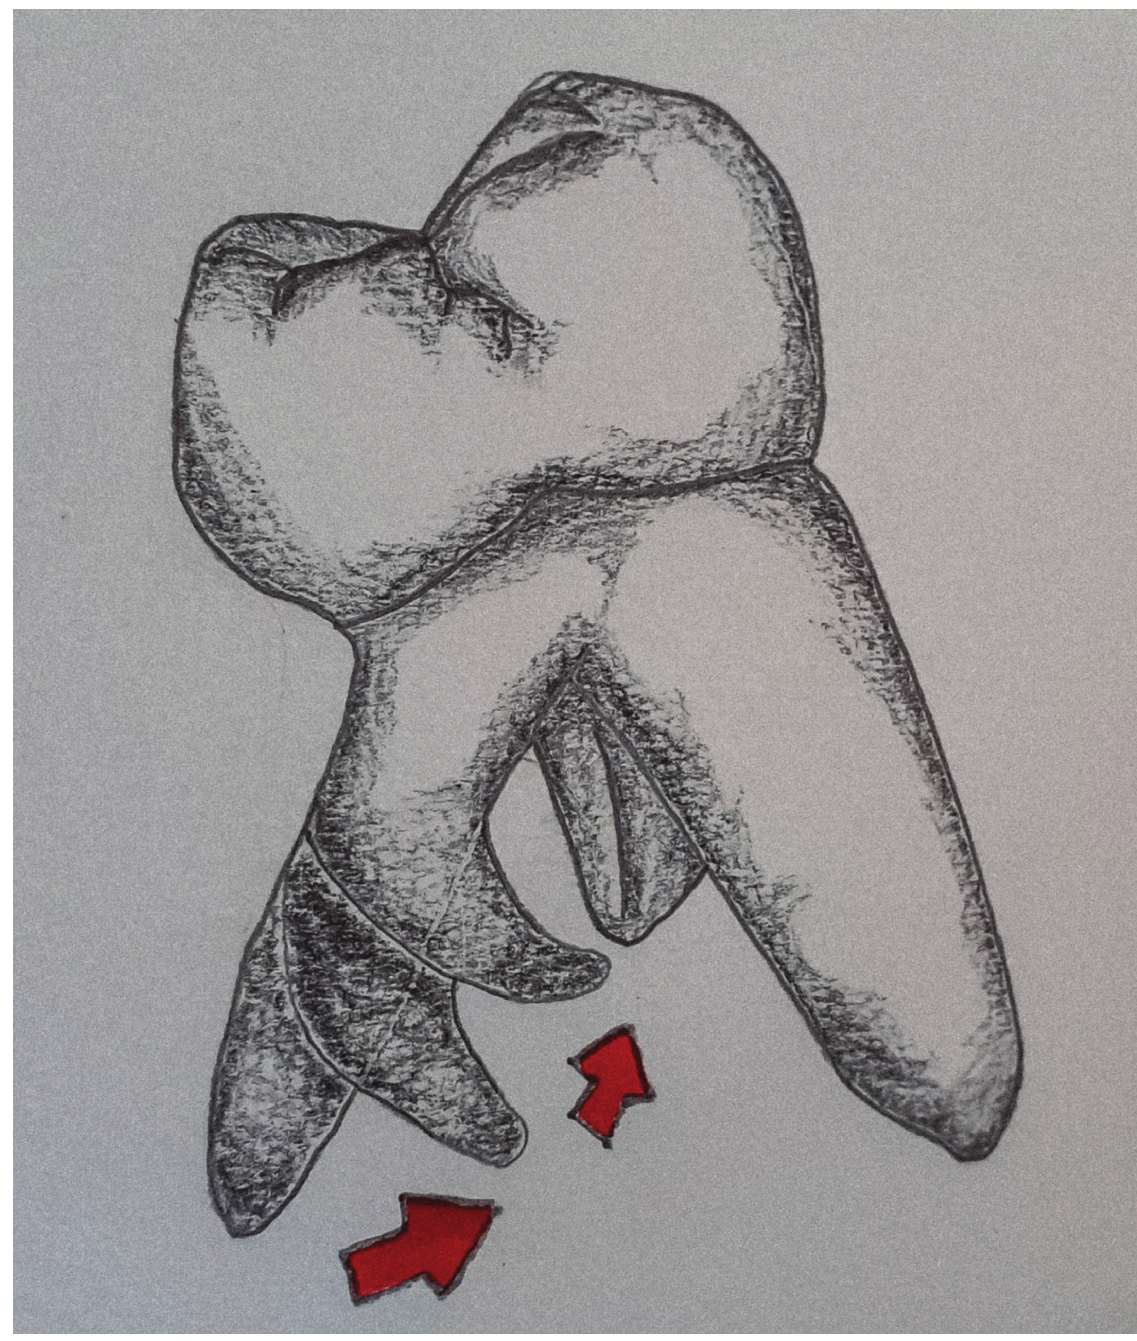
Figure 2: Distal proximal view of right three-rooted PMFM showing various curvatures of the distolingual